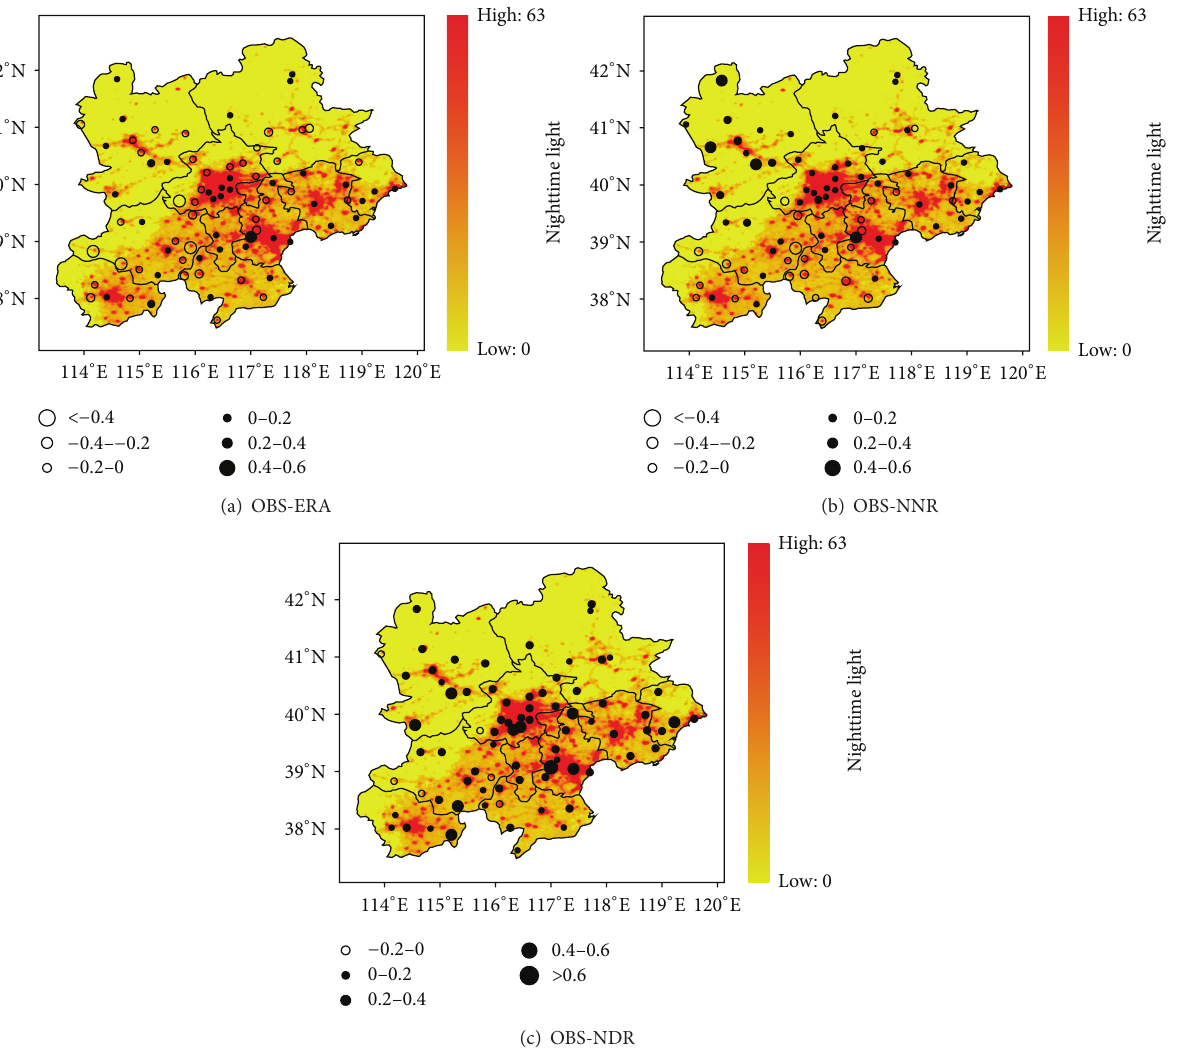
Figure 7: Annual mean temperature trends from the observation minus reanalysis method ( ∘ Cdecade −1 ) for the (a) ERA, (b) NNR, and (c) NDR. The DMSP/OLS nighttime lights imagery from 2009 is also